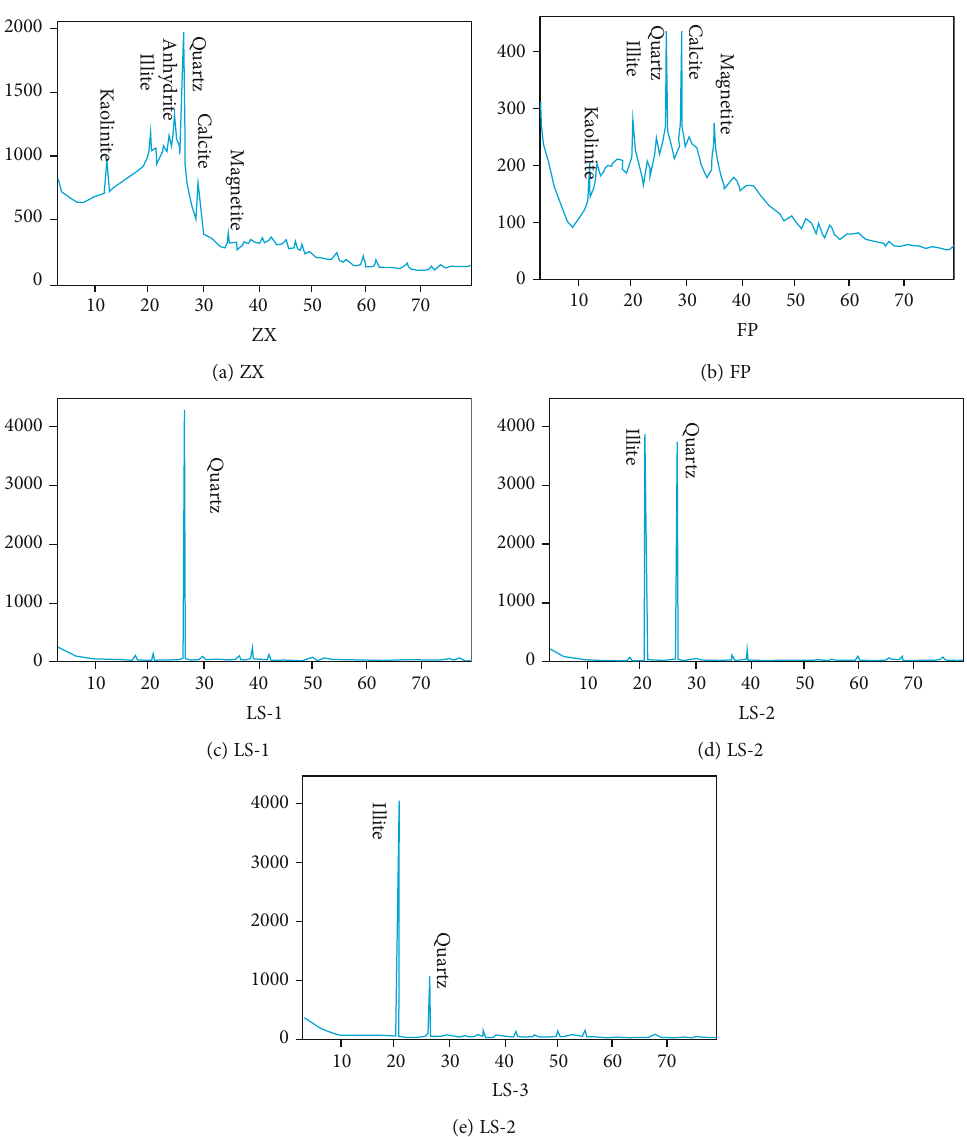
Figure 8: X-ray di ff raction mineral analysis of di ff erent coal fi